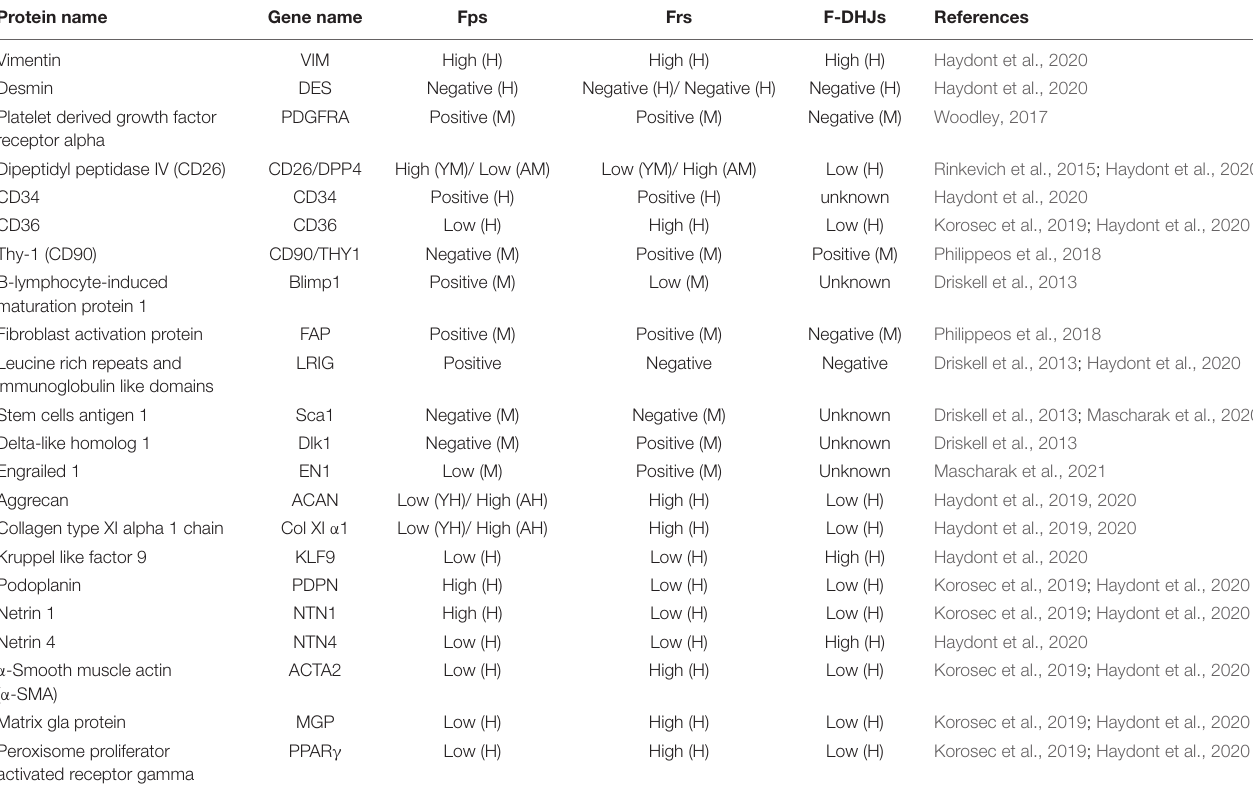
TABLE 1 | Surface markers of dermal fibroblasts from both mouse and